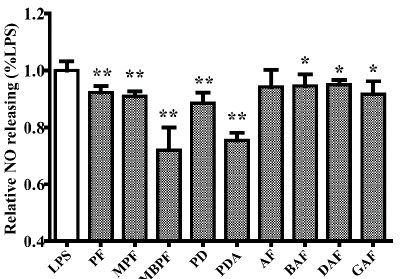
Figure 1. Effect of monoterpenoids (PF, MPF, MBPF, PD, PDA, AF, BAF, DAF, and GAF) on the production of nitric oxide (NO) in lipopolysaccharide (LPS)-induced RAW 264.7 cells. The cells were treated, respectively, with the 33 μ M of the nine different compounds for 2 h, and then stimulated with LPS (1 μ g/mL) for 24 h. The culture medium was collected to detect the concentrations of nitrite and calculate the relative NO release rate. (PF, paeoniflorin; MPF, 4- O -methylpaeoniflorin; MBPF, 4- O -methylbenzoylpaeoniflorin; PD, paeonidanin; PDA, paeonidanin A; AF, albiflorin; BAF, benzoylalbiflorin; DAF, debenzoylalbiflorin; GAF, galloylalbiflorin; * p < 0.05, ** p < 0.01, relative to the LPS group).